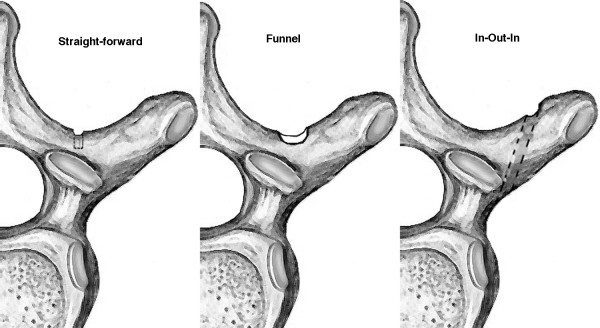
The three techniques to start thoracic pedicle screw placement evaluated in this study: straight-forward, funnel, and in-out-in.